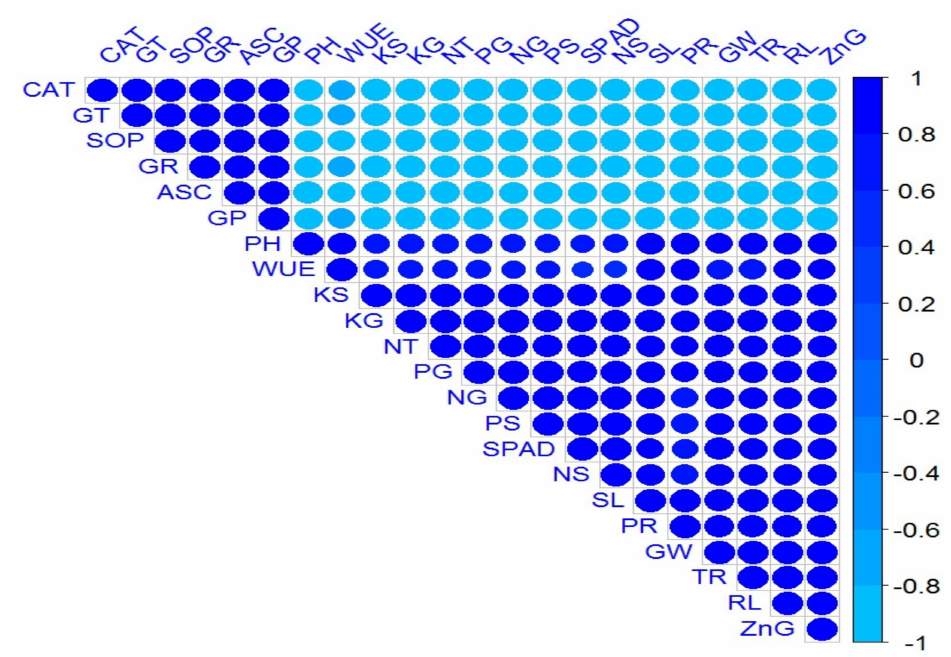
Figure 3. Corrplot representing correlation among measured attributes of wheat crop followed by treatments as Normal soil—(1) Control, (2) ZnSO 4 -coated urea, (3) BAZ-coated urea, and (4) Bacillus sp. strain AZ6—and Saline soil—(5) Control, (6) ZnSO 4 -coated urea, (7) BAZ-coated urea, and (8) Bacillus sp. strain AZ6. Positive correlations are displayed in royal blue, and negative correlations, in sky blue color. The color legend on the right-hand side of corrplot, shows correlation coe ffi cients and the corresponding colors. The intensity of the color and circle size are proportional to the correlation coe ffi cients. The abbreviations are as follows: PH = Plant height, RL = Root length, NT = No. of tillers, SL = Spike length, GW = 1000-grain weight, WUE = Water use e ffi ciency (WUE), SPAD = Chlorophyll contents, PR = Photosynthetic rate, TR = Transpiration rate, CAT = Catalase, ASC = Ascorbate peroxidase, SOD = Superoxide dismutase, GR = Glutathione reductase, GT = Glutathione transferase, GP = Glutathione peroxidase, NG = Nitrogen in grain, NS = Nitrogen in straw, PG = Phosphorus in grain, PS = Phosphorus in straw, KG = Potassium in grain, KS = Potassium in straw, and ZnG = Zinc in